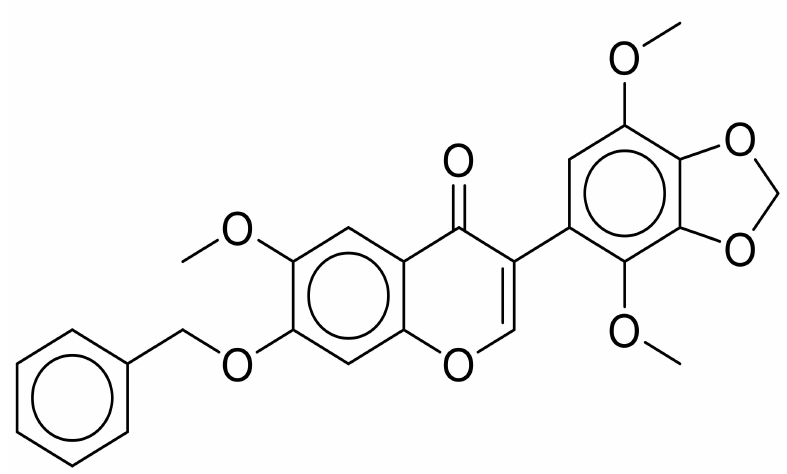
Figure 2. Chemical structure of the compound gatastatin. Figure obtained with ChemDraw JS 19.0.0 [10].